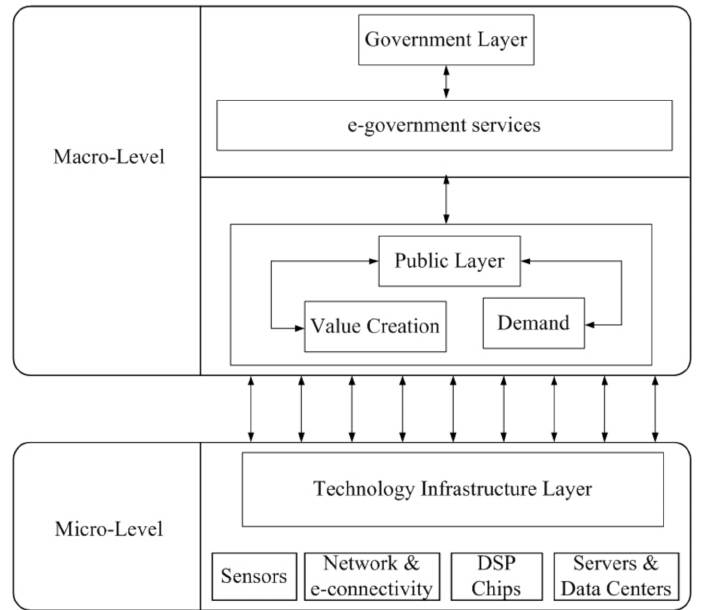
Figure 1. Interconnection of micro and macro level in the internet of things (IoT)